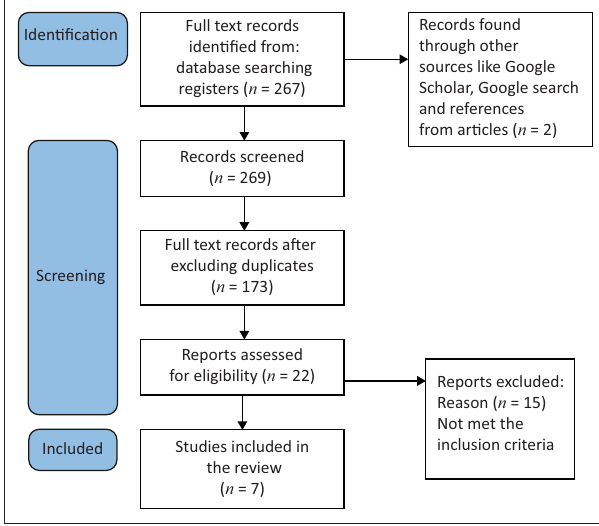
FIGURE 2: The Preferred Reporting Items for Systematic Reviews and Meta- Analysis flow diagram showing the summary of study selection and the inclusion process.